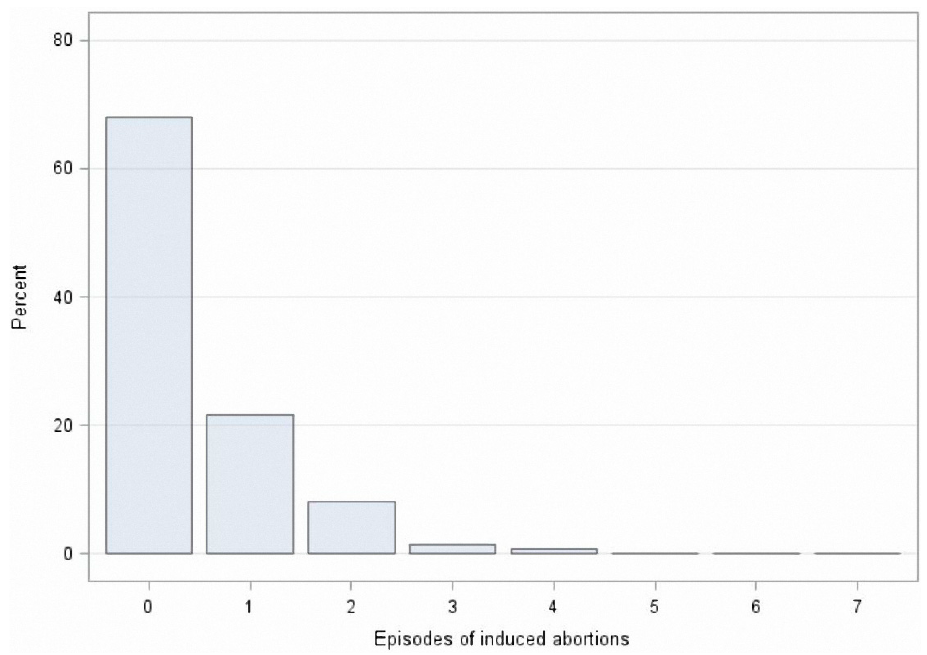
Figure 1. Distribution of induced abortions among the studied reproductive-age migrant women.